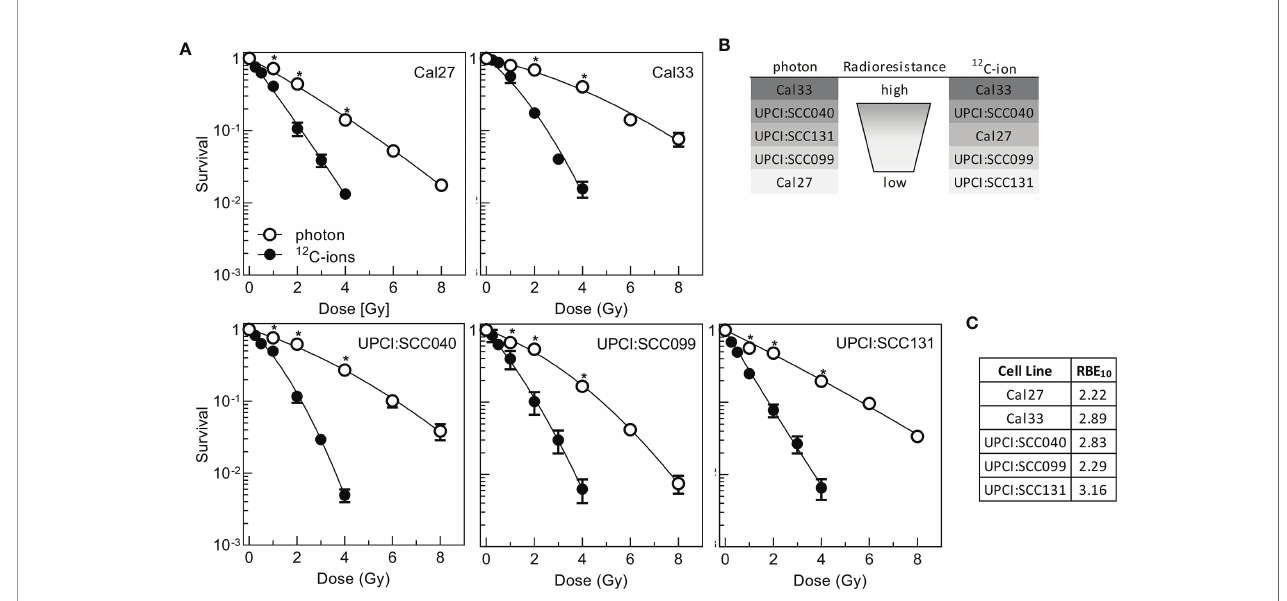
FIGURE 1 | Radioresistance of fi ve HPV-negative HNSCC cell lines after photon- or 12 C-ion irradiation. Exponentially growing cells were irradiated and incubated for 16 h followed by delayed plating for colony formation. (A) Clonogenic survival after irradiation. (B) Ranking of radioresistance according to the AUC calculated from linear presentation of dose – response curves. (C) Relative biological effectiveness at 10% survival (RBE 10 ). Experiments were performed at least three times. Mean +/- SEM are indicated. Signi fi cance levels were calculated with Student ’ s t-test statistics and signi fi cant p-values below 0.05 marked with an